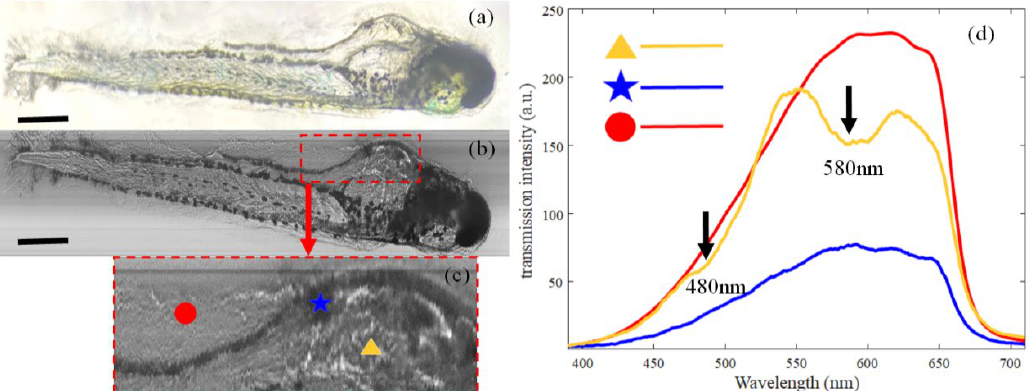
Figure 3. Experimental results the hyperspectral detection of a zebrafish under the transmission mode. ( a ) Optical microscopic image of a zebrafish under a traditional microscopy with 40× objective. Scale bar: 100 μm. ( b ) Hyperspectral image of a zebrafish reconstructed from our system. Scale bar: 100 μm. ( c ) Partial enlarged image of the zebrafish and three points of interest, including the transparent fin (marked as red dot), speckle (marked as blue star) and yolk sac (marked as yellow triangle). ( d ) Corresponding transmittance spectrum at the three points of interest.